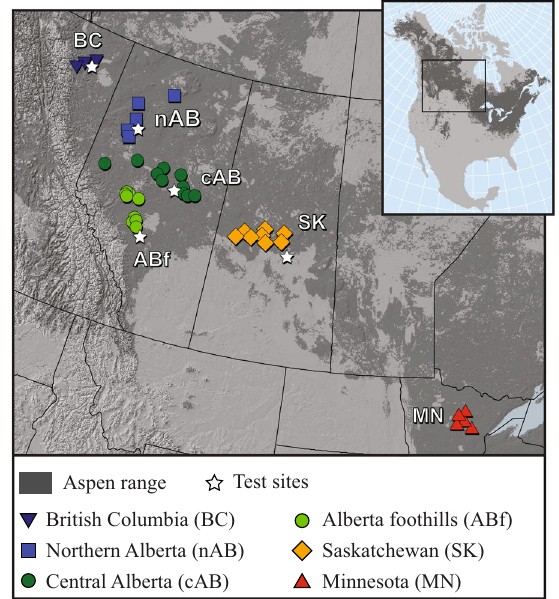
Figure 1. Collection locations and test sites of the aspen provenance trial series that was used to quantify within-population genetic diversity and adaptational lag of aspen populations. The map was created with ArcGIS v9.3 (http://esri.com).